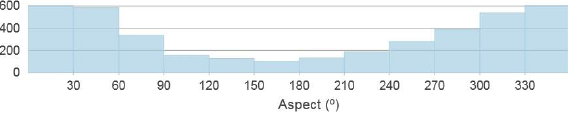
Figure 6. Histogram of the aspect at the GPS positions.